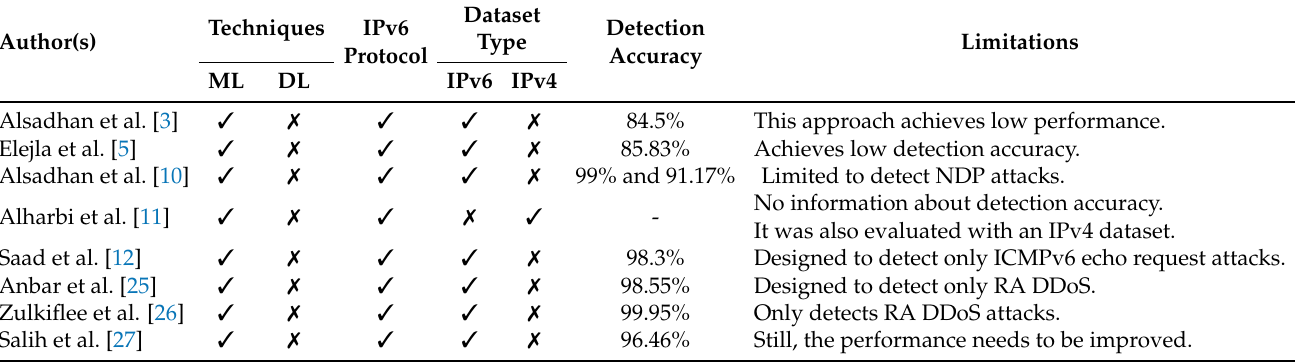
Table 1. A qualitative comparison of existing techniques with their